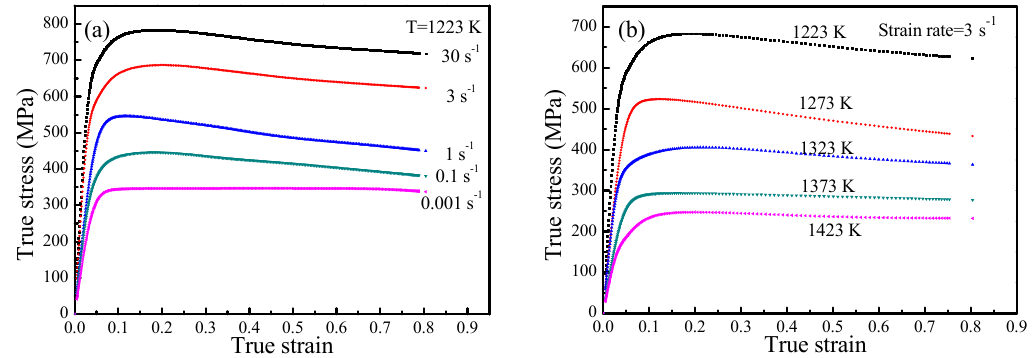
Figure 1. The true stress-strain curves of the superalloy under different conditions: ( a ) temperature of 1223 K; ( b ) strain rate of 3 s − 1 .